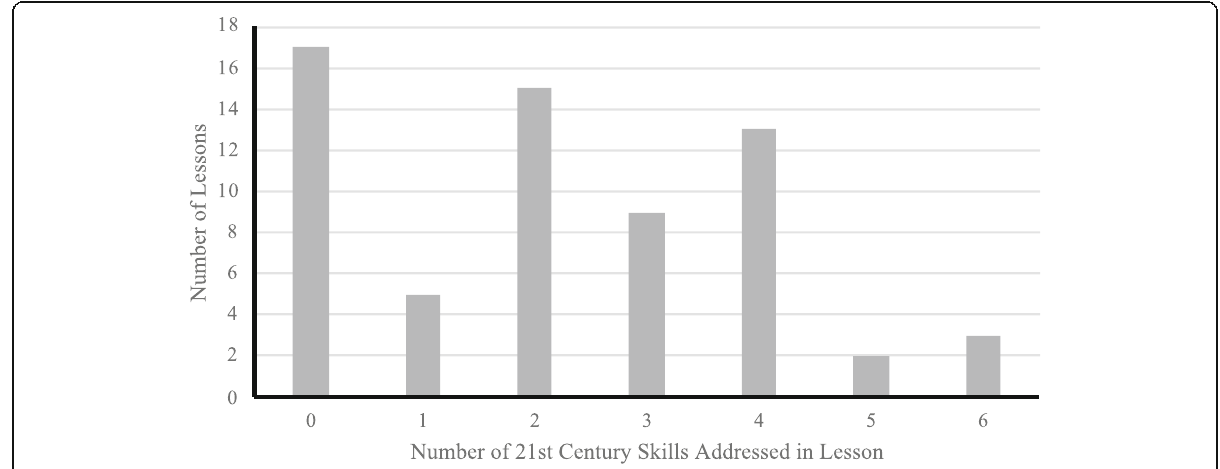
Fig. 3 Distribution of number of 21 st Century skills addressed in a lesson